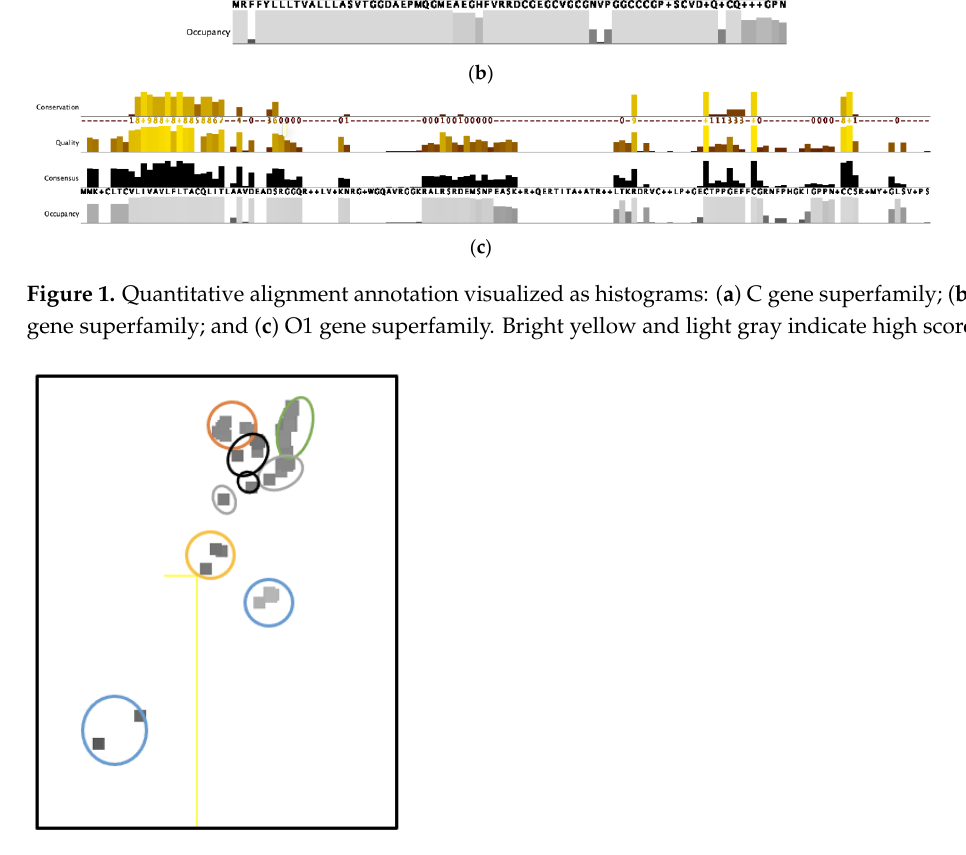
Figure 1. Quantitative alignment annotation visualized as histograms: ( a ) C gene superfamily; ( b ) G2 gene superfamily; and ( c ) O1 gene superfamily. Bright yellow and light gray indicate high scores.